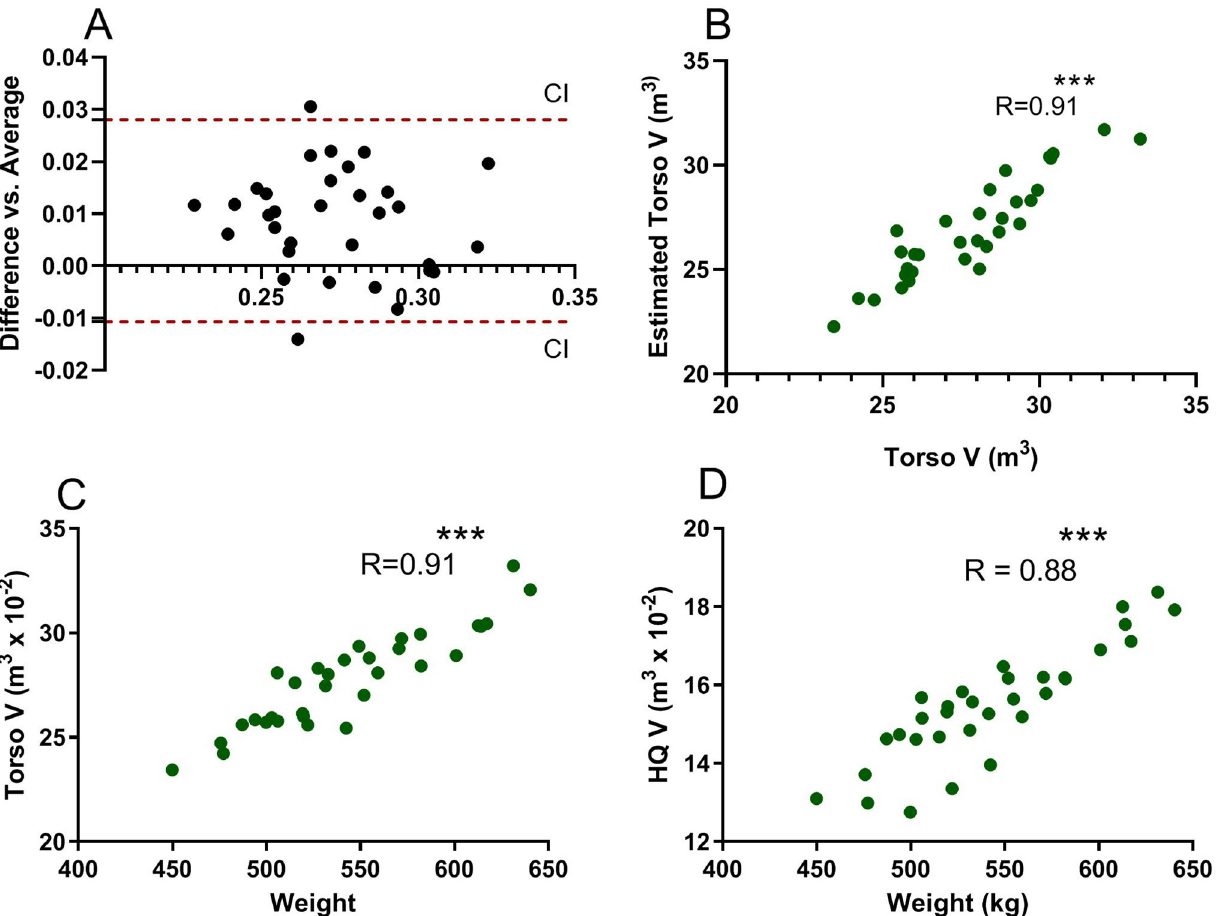
Fig 3. Accuracy of 3D scanning to assess body volume. A. Bland Altman plot comparing the differences between torso V and average of estimated torso volume (V) with 95% confidence intervals depicted by red dashed lines. Only two of 32 V measures were outside of the 95% confidence limits. B. Correlation of 3D scan torso V with estimated torso V (R = 0.91). C. Positive correlation of 3D scan torso volume with body weight. D. Positive correlation of 3D scan hindquarter volume with body weight. ��� P < 0.001.